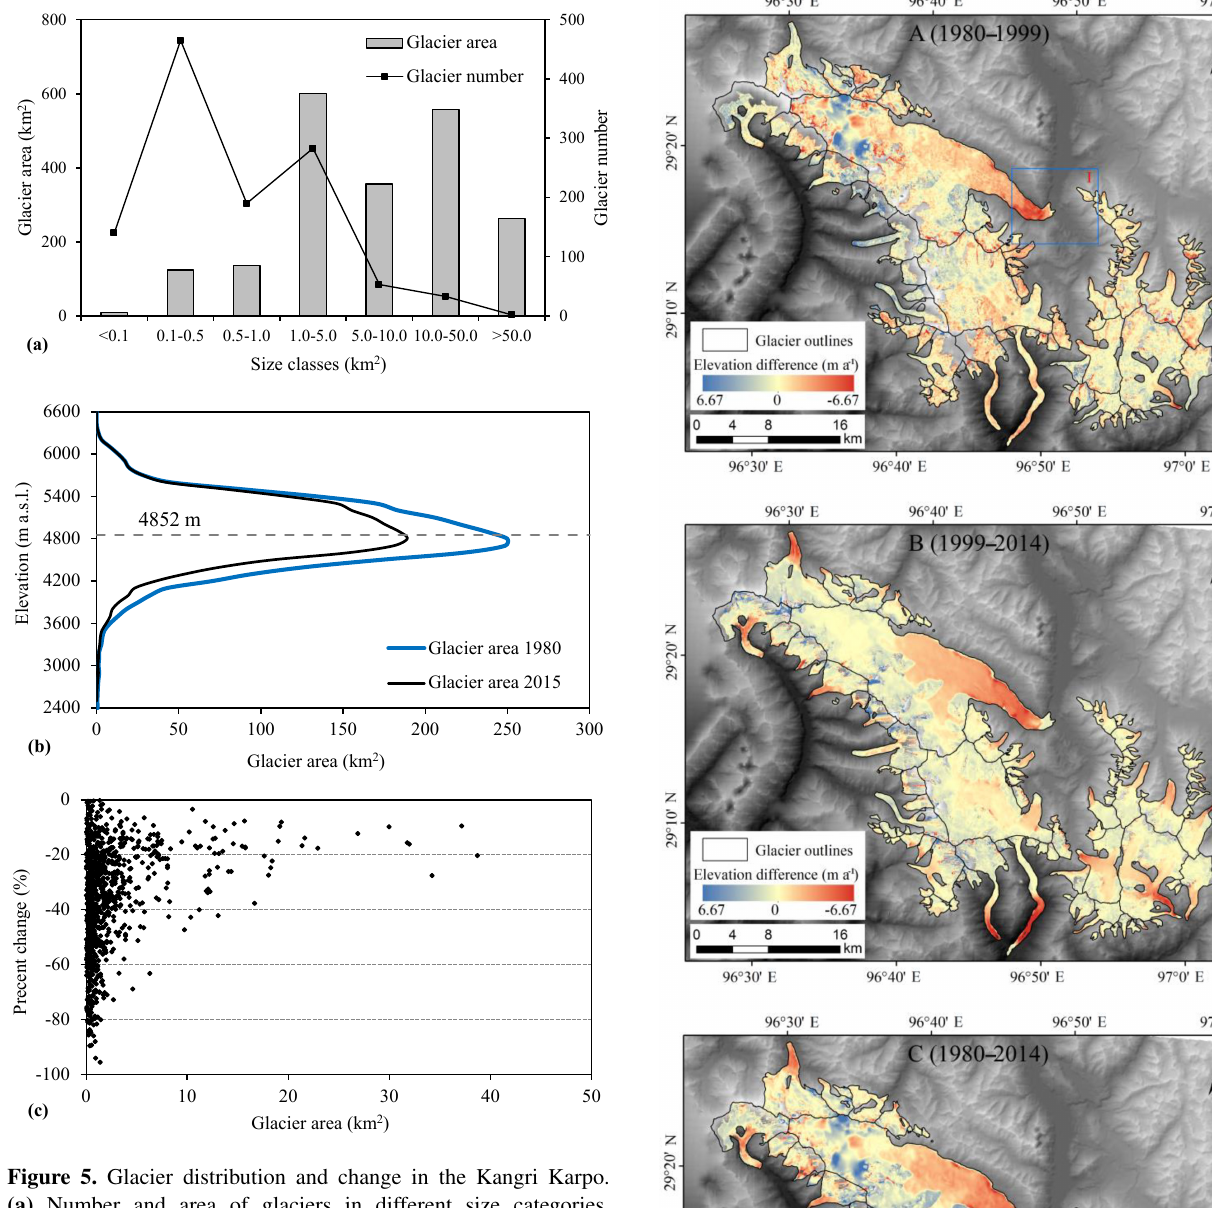
Figure 5. Glacier distribution and change in the Kangri Karpo. (a) Number and area of glaciers in different size categories. (b) Hypsography of glaciers in 1980 and 2015; the dashed line de- picts the median elevation value. (c) Percentage change in glacier area from 1980 to 2015.